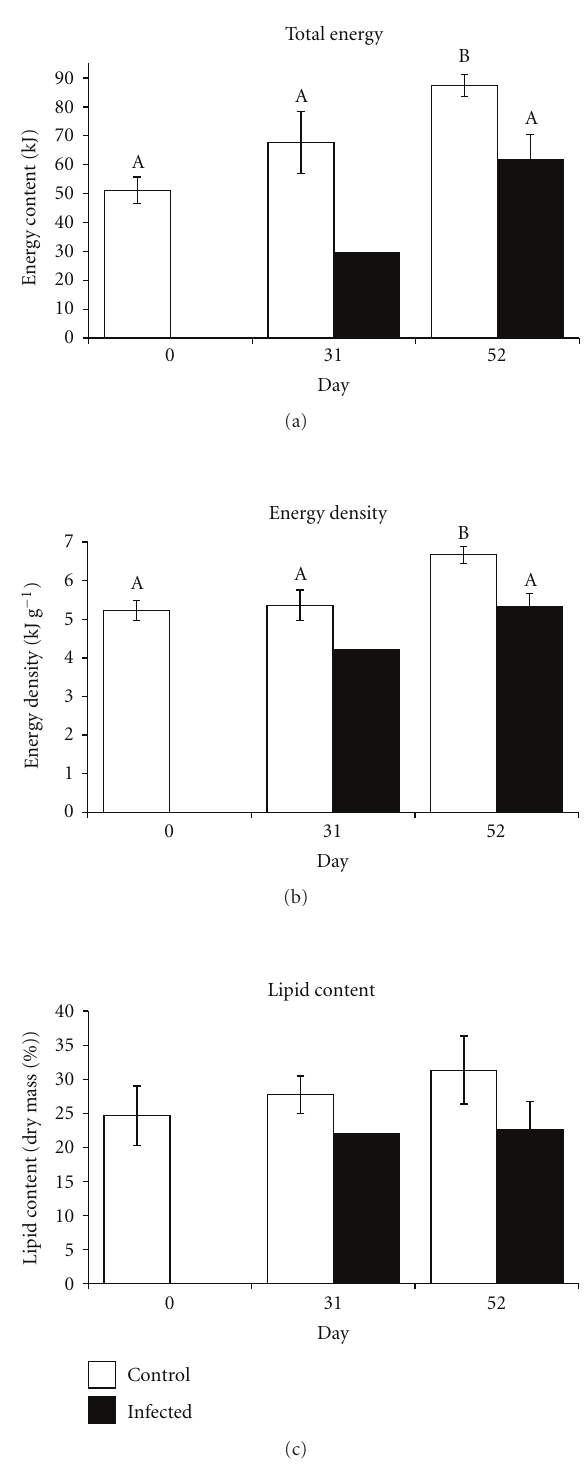
Figure 2: Energetic cost of Ichthyophonus infection in “autumn” young-of-the-year Pacific herring depicted by total energy content, energy density, and lipid content (% dry mass). Fish represented in this figure were cultured in ambient water temperature (9.5 ◦ C). Di ff erent letters represent statistical di ff erentiation. Lack of letters indicates no statistical di ff erentiation. Low sample size of infected fish on day 31 precludes statistical